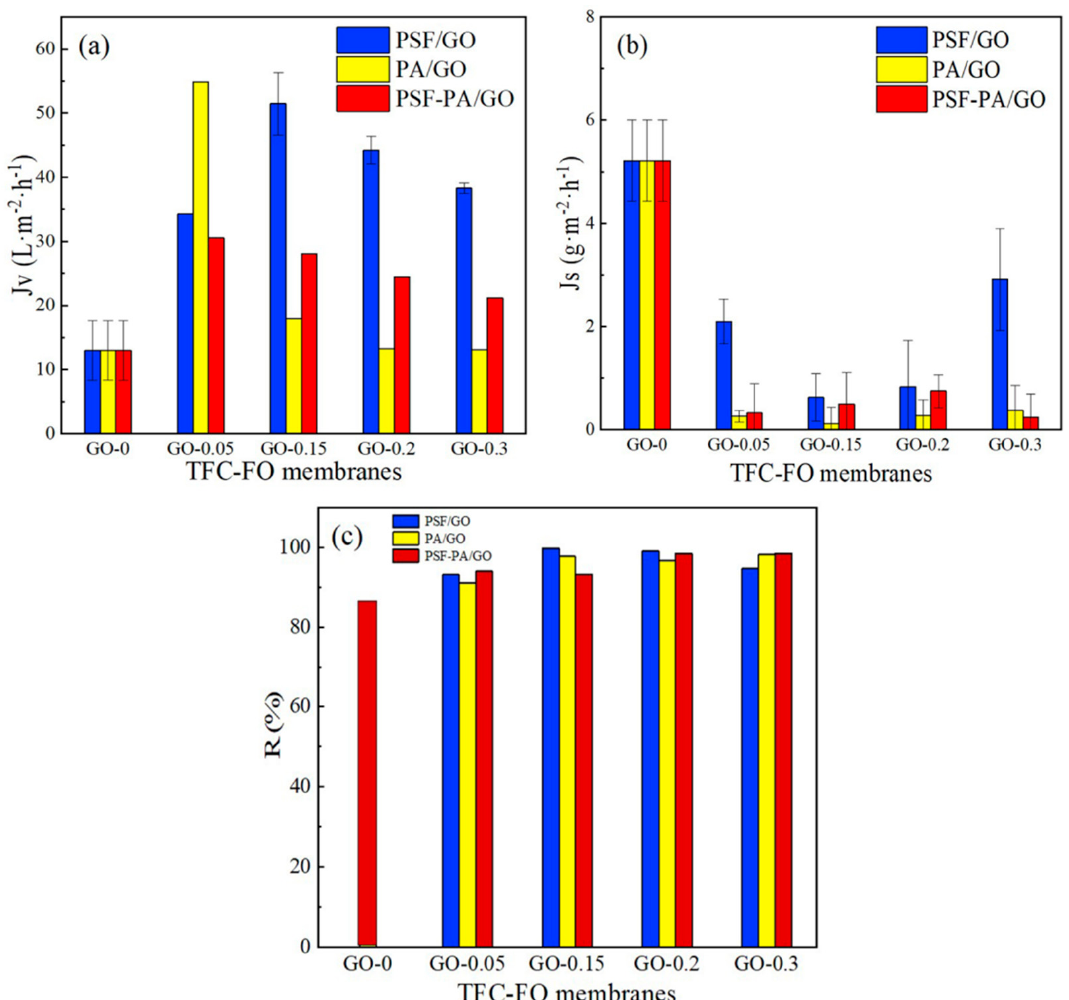
Figure 7. ( a ) Jv , ( b ) Js , and ( c ) R of different GO-doped TFC-FO membranes. The R values of GO-doped membranes were all higher than 90% with the following trends, TFC-FO PA/GO > TFC-FO PSF/GO > TFC-FO PSF-PA/GO . For GO-doped membranes, the R values were all higher than 97% under the optimal doping amounts and higher than those of the control group without doping GO. Meanwhile, TFC-FO PA/GO and TFC-FO PSF-PA/GO membranes showed lower Js compared with TFC-FO PSF/GO . Thus, the modification of the active layer led to the smallest Js because the loaded GO promoted the formation of the internal structure of the membranes. GO nanoparticles were mainly bound by intermolecular forces in the GO-doped PSF support layers, and GO occupied most of the molecu- lar gaps. When the GO nanoparticles were loaded into active PA layers, GO chemically reacted with MPD and TMC during IP processes to form polyamide groups and multi- layer GO water channels, which improved the salt interception properties of the mem- branes. Thus, the presence of free GO nanoparticles during the IP processes was the cru- cial reason for the good salt interception properties of TFC-FO PA/GO and TFC-FO PSF-PA/GO membranes . When GO was doped in the two layers at the same time, Jv did not change signifi- cantly with the change in GO loading. Jv gradually decreased with the increase in GO loading because of the agglomeration of GO. In addition, GO-containing macromolecules were formed in both layers, and the IP reaction was carried out inefficiently, which hin- dered the formation of ordered water channels . The permeability test results were in agreement with the results of the porosity test shown in Table S3. TFC-FO PA/GO membrane presented the highest porosity, while the porosity value was only 20.63% when the two layers were doped with GO simultaneously. In addition, although the porosity of TFC-